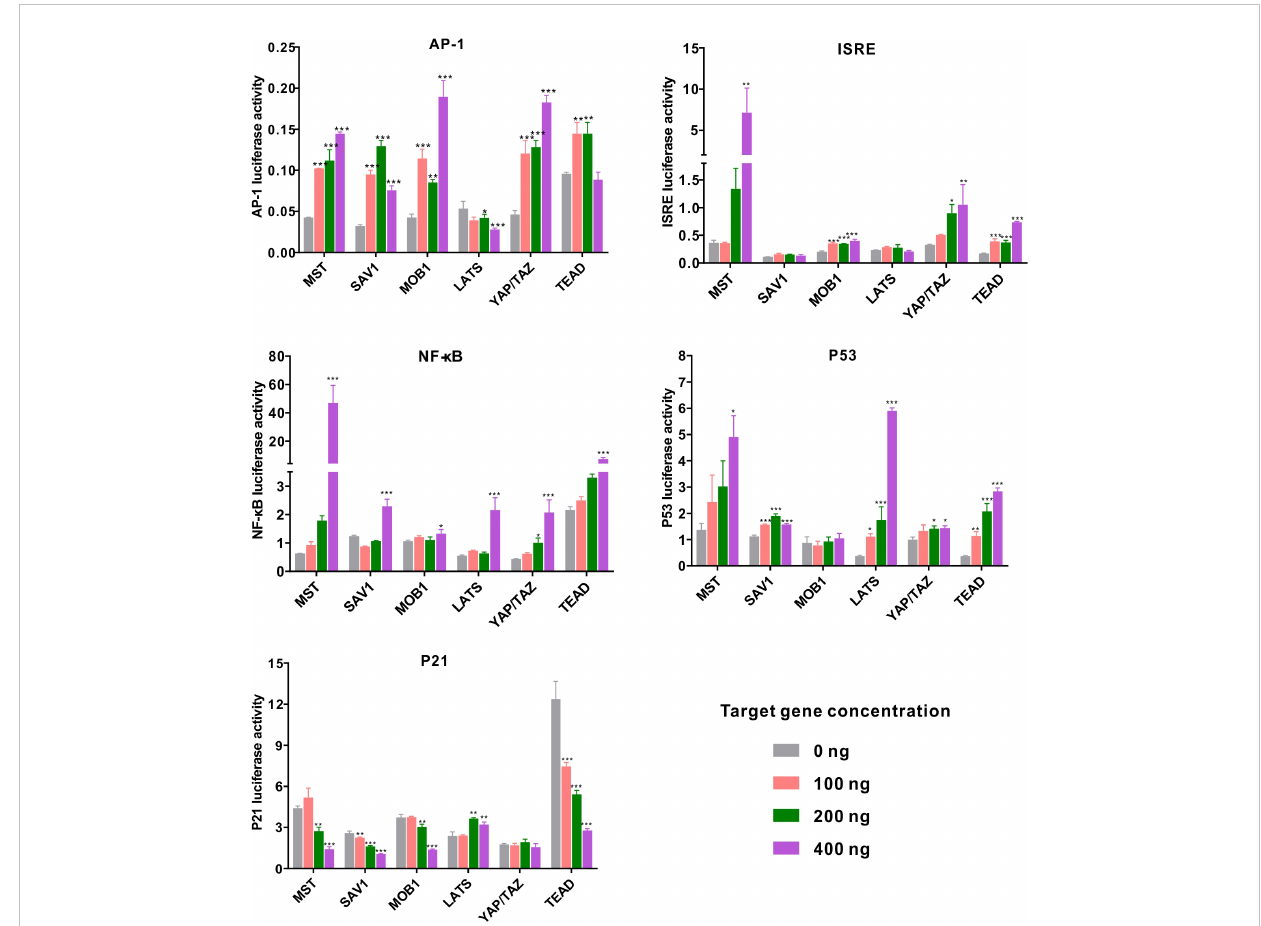
FIGURE 5 Relative luciferase activity in the eukaryotic expression system in HEK293T cells. Changes in the relative luciferase activity of AP-1, ISRE, NF- k B, p53, and p21 were analyzed after overexpression of Ch MST, Ch SAV1, Ch MOB1, Ch LATS, Ch YAP/TAZ, and Ch TEAD. Data analysis was performed by using GraphPad Prism 9 software, and vertical bars represent mean ± SD ( n = 3). *** p < 0.001; ** p < 0.01; * p <